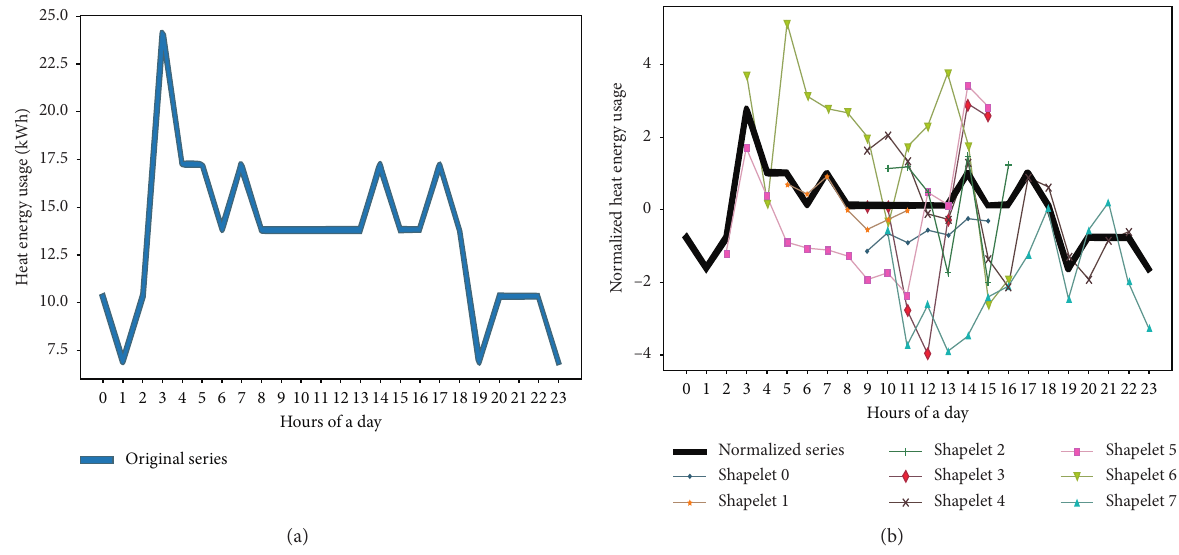
Figure 3: Sample case two (night setback profile): morning peak at 3 a.m. and evening dip at 7